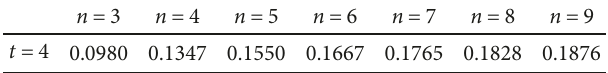
Table 2: Threshold values for di ff erent n ( t = 4 , α = 0 1 , and σ = 2 ). n = 3 n =